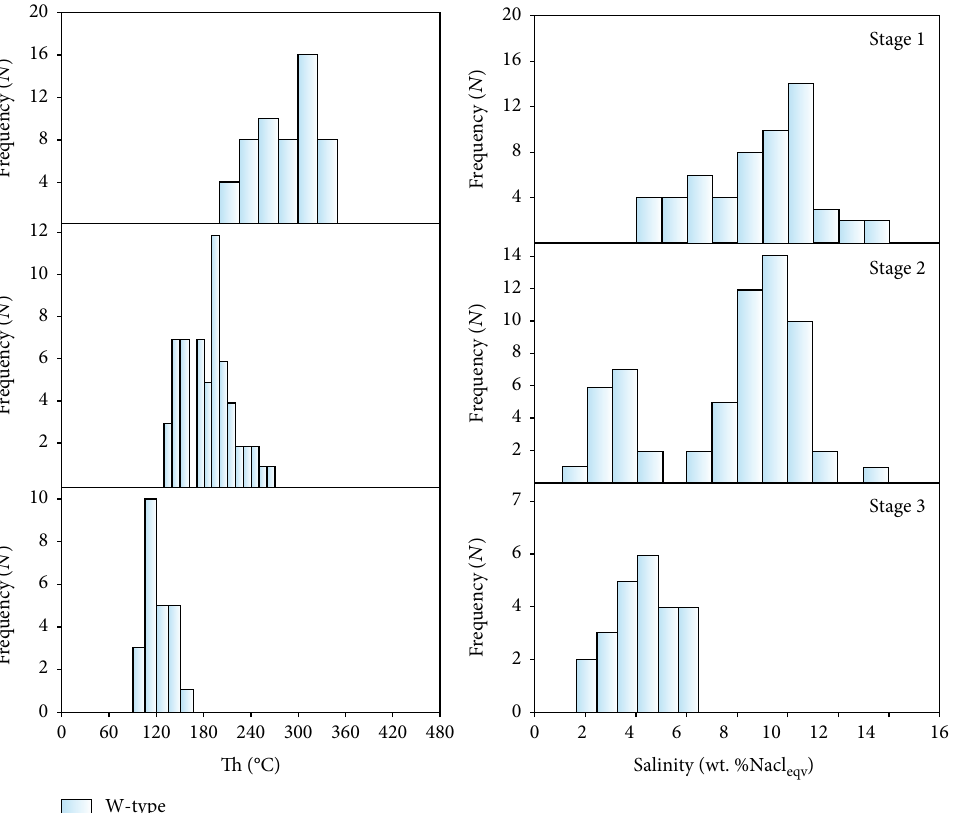
Figure 8: Histograms of FI homogenization temperatures and salinities from the Longmendian deposit. Table 2: Vapor and liquid compositions of fl uid inclusions ( W Sample